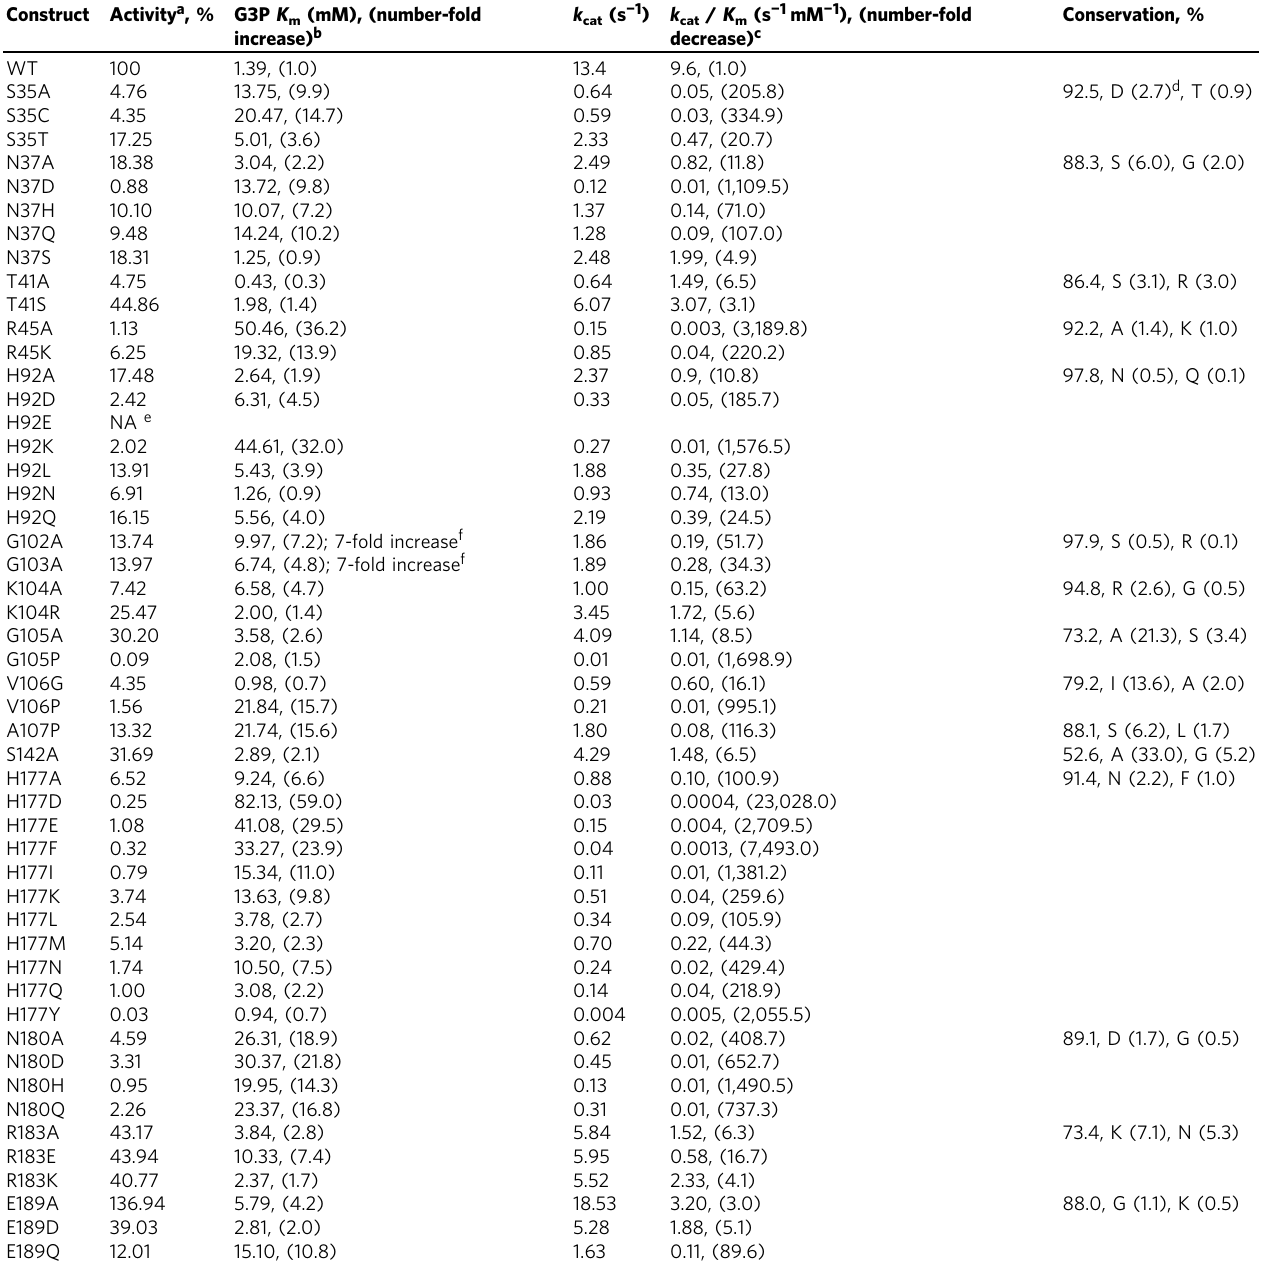
Table 2 Activity of mutants and conservation of functionally important residues Construct Activity a , % G3P K m (mM), (number-fold increase)